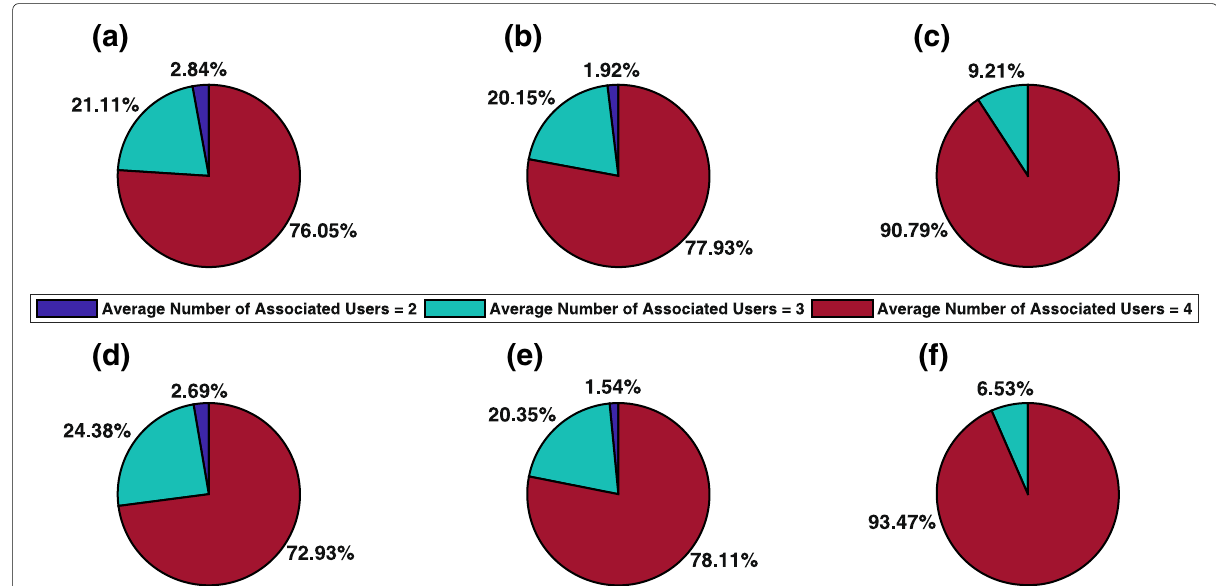
Fig. 6 Average number of associated users— SP-PF-SINR-MAX(U-SM) algorithm. a BS 1 (Scenario 1). b BS 2 (Scenario 1). c BS 3 (Scenario 1). d BS 1 (Scenario 2). e BS 2 (Scenario 2). f BS 3 (Scenario 2)